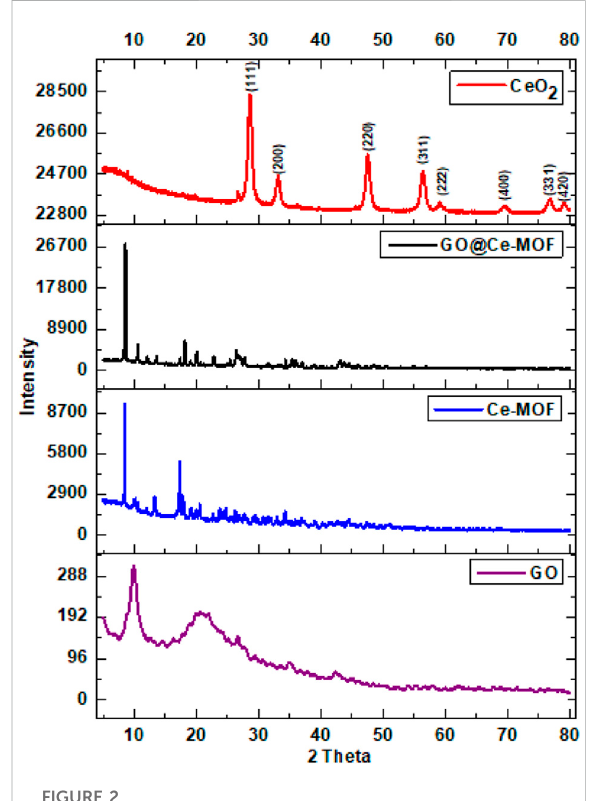
FIGURE 2 Powder X-ray diffraction patterns of GO, Ce-MOF, GO@Ce- MOF, and CeO 2